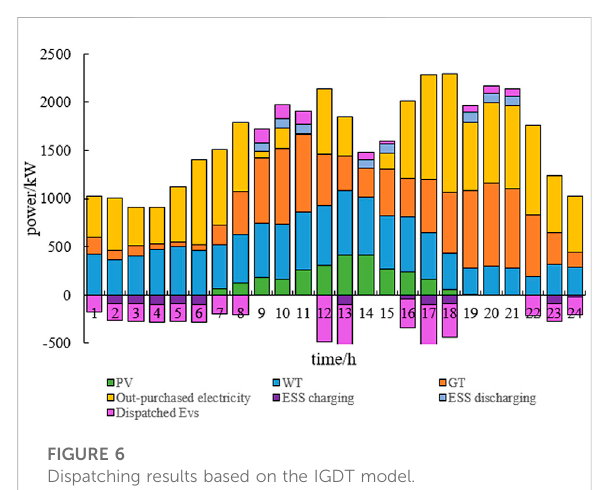
Dispatching results based on the IGDT